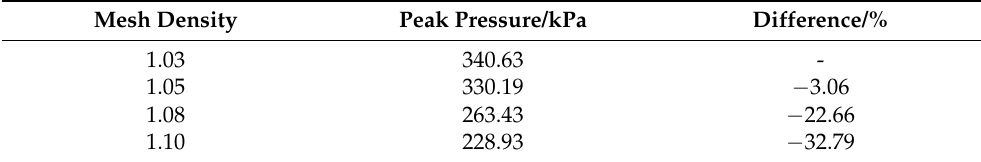
Figure 15. The effect of mesh refinement. Table 4. Details of pressure-time histories.